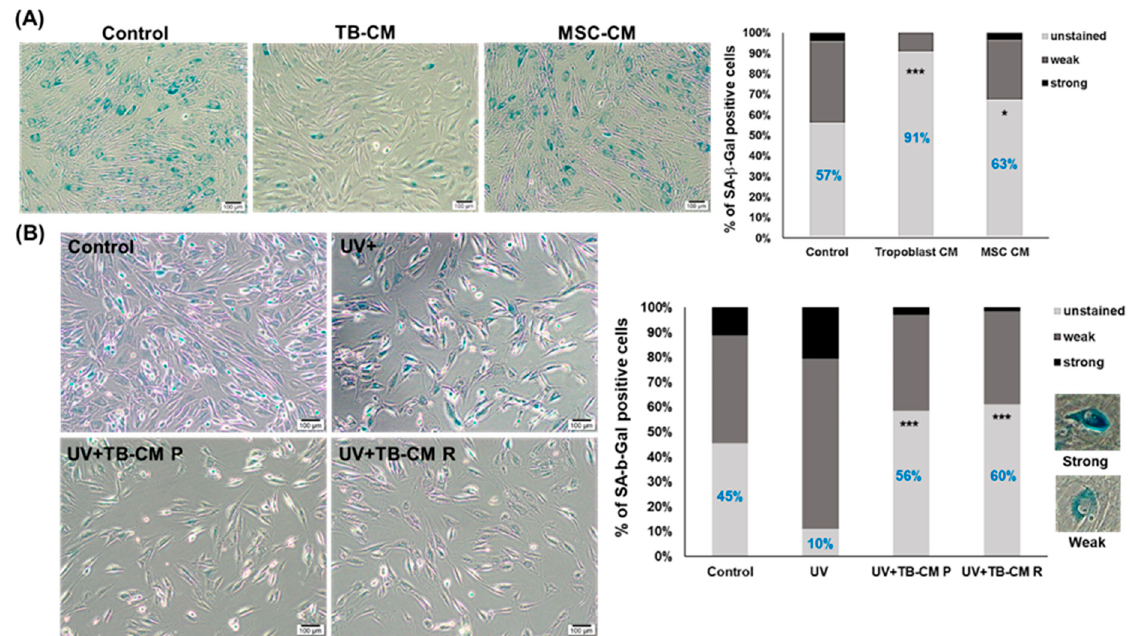
Figure 4. Anti-aging effect of TB-CM on senescence in HNDFs. (A) Senescent HNDF cells (at passage 21) were treated with 20% TB-CM and MSC-CM for 72 h and then stained with SA- β -Gal. Positive staining with SA- β -Gal was detected in terms of strong and weak blue color upon observation under a light microscope. According to the degree of SA- β -Gal stain on the cells, the cells were divided into unstained, weak, and strong groups, for the quantification of the stained cells. The percentage of SA- β -Gal-positive cells was determined in three independent images. Scale bar: 100 μ m. (B) Senescent HNDF cells were incubated with TB-CM (20%) before and after UV irradiation, and the number of cells positively stained with SA- β -Gal was determined in three different images in each group. Scale bar: 100 μ m. Data are represented as means and standard deviation (n = 3); * p < 0.05 and *** p < 0.001, as compared to the corresponding control. Representative images of strongly and weakly stained cells have been included in the figure.